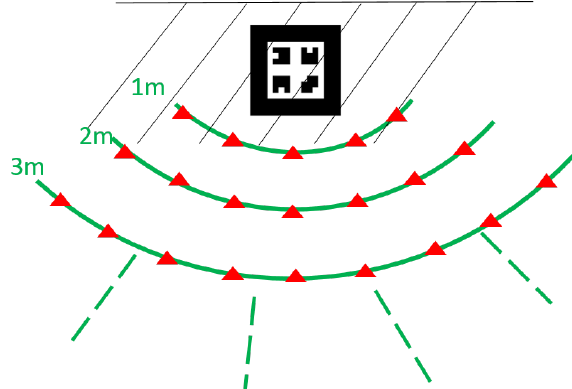
Figure 10. The schematic diagram of collecting data